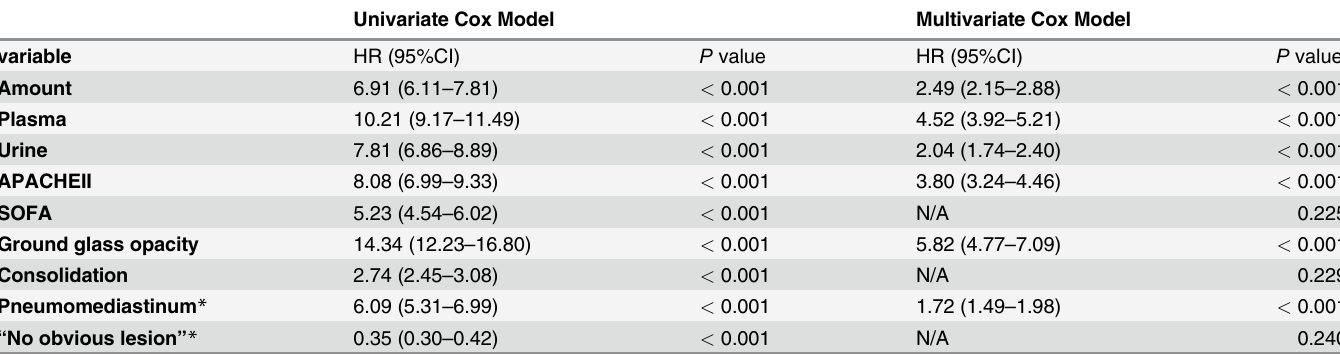
Table 4. Cox Proportional Hazards Models for Mortality Prediction of PQ